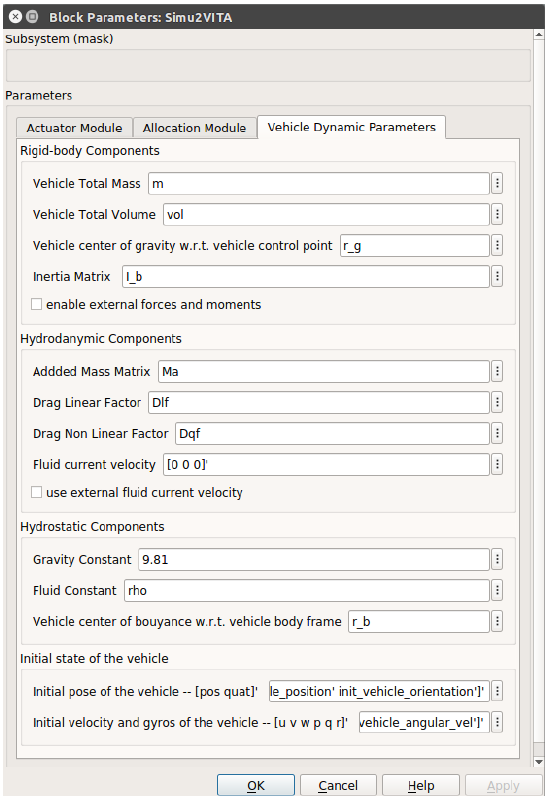
Figure A4. Simu2VITA interface for entering with simulation parameters for the Dynamics